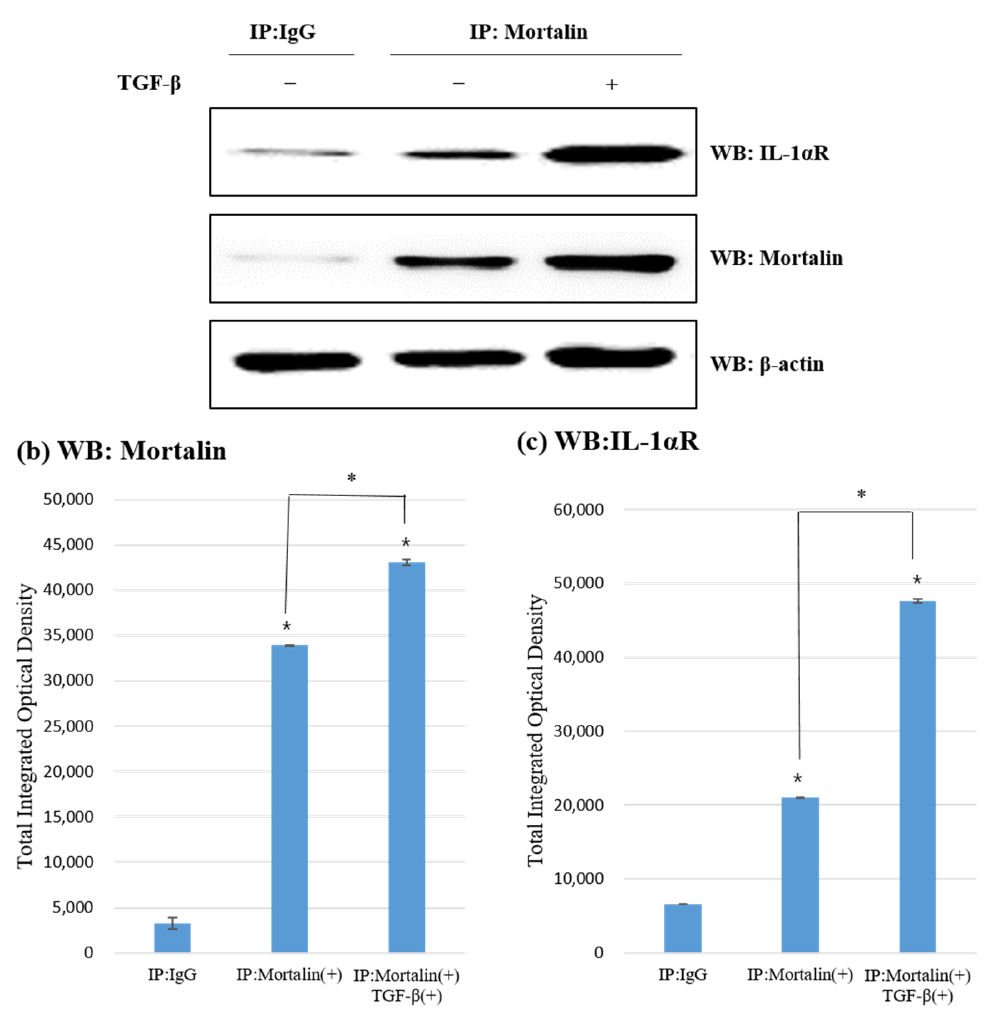
Figure 4. Immunoprecipitation and Western blotting analysis of mortalin and IL-1 α receptor in keloid fibroblasts. ( a ) In KFs, mortalin and IL-1 α receptor interact with each other and mortalin was bound to the IL-1 α receptor. The mortalin and IL-1 α receptor levels were higher in KFs than in HDFs and were further upregulated following the activation of KFs by TGF- β 1 (10 ng/mL); ( b , c ) On the semi-quantitative MetaMorph ® image analysis, expression of mortalin and the IL-1a receptor was significantly increased as a result of immunoprecipitation of mortalin in KFs (* p < 0.05) and was significantly increased upon additional TGF- β treatment (* p < 0.05).